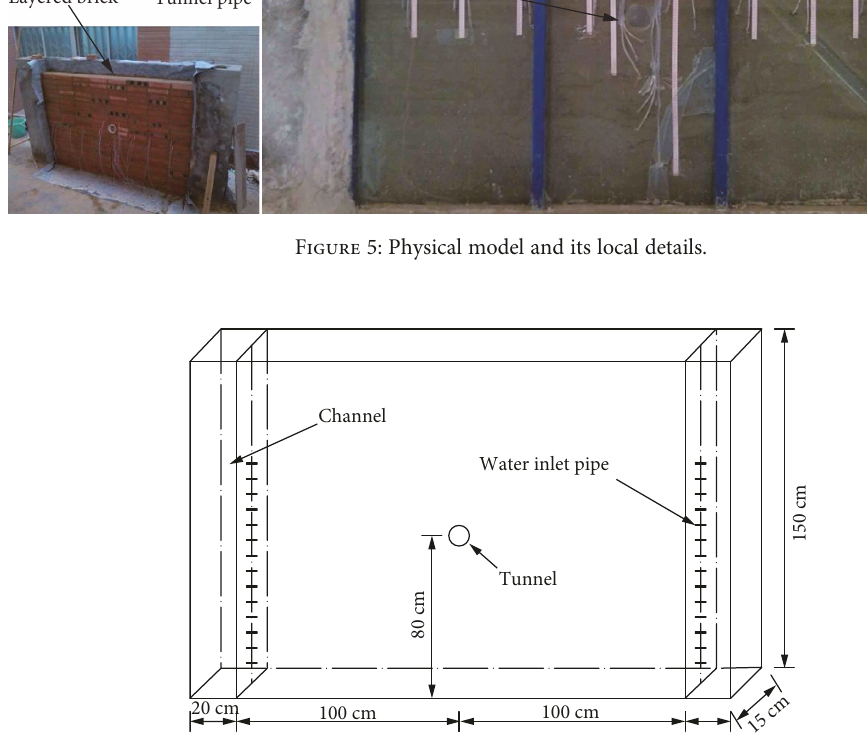
Figure 6: Physical model and key